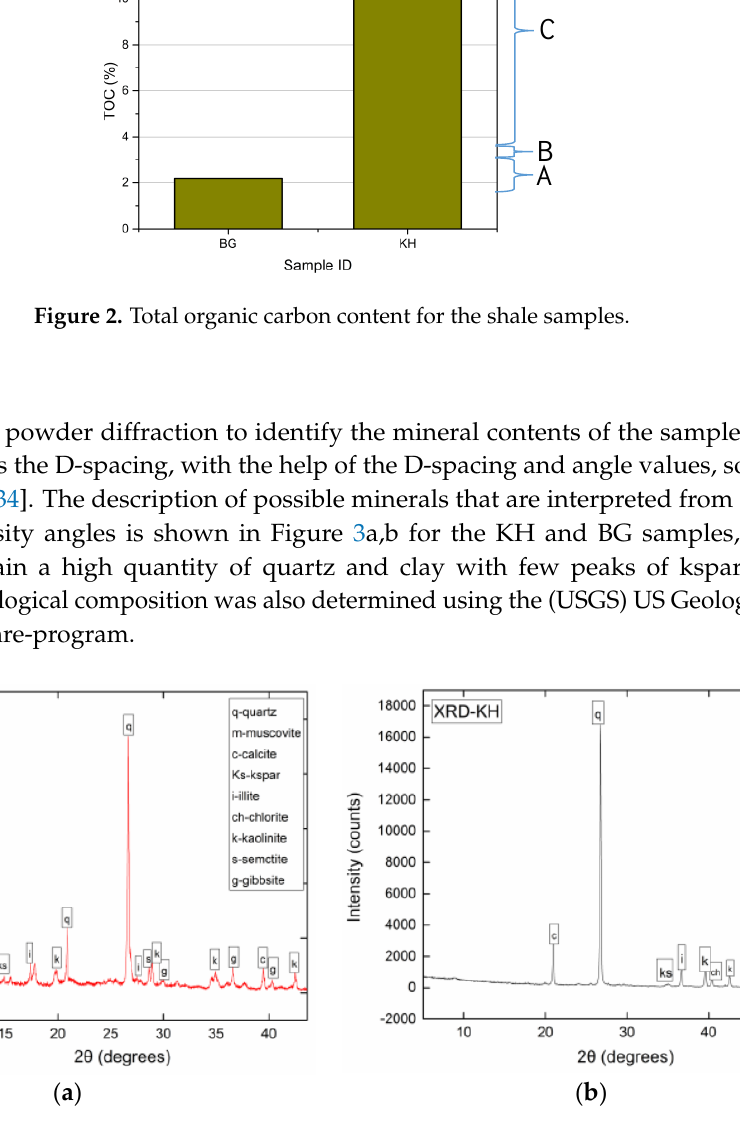
Figure 3. XRD pattern 2theta vs. intensity: ( a ) BG sample XRD pattern shows the content of several peaks of clays and quartz; ( b ) KH sample XRD pattern shows the peaks of quartz calcite and some clays.